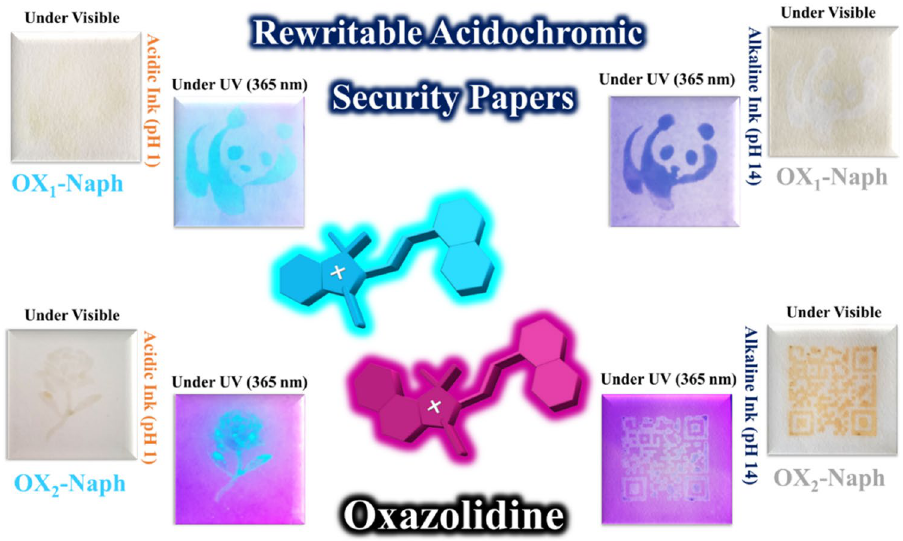
Figure 10. Printing of security marks and tags on OX 1 -Naph and OX 2 -Naph acidochromic papers by stamping of acidic (pH 1) and alkaline (pH 14) solutions as water-based inks.